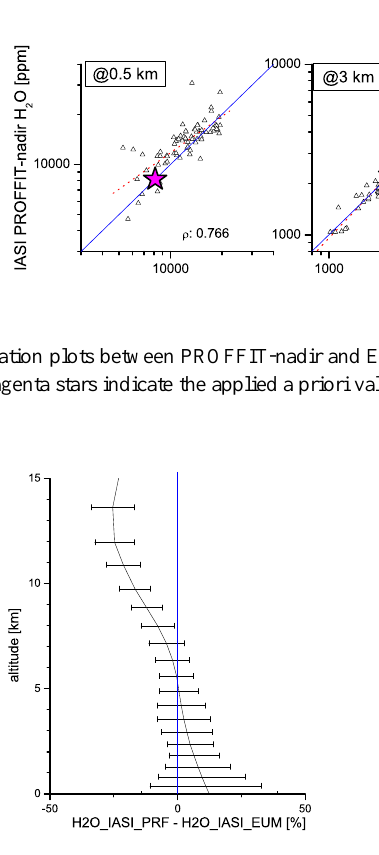
Fig. 11. Statistics of difference between PROFFIT-nadir and EU- METSAT H 2 O data.